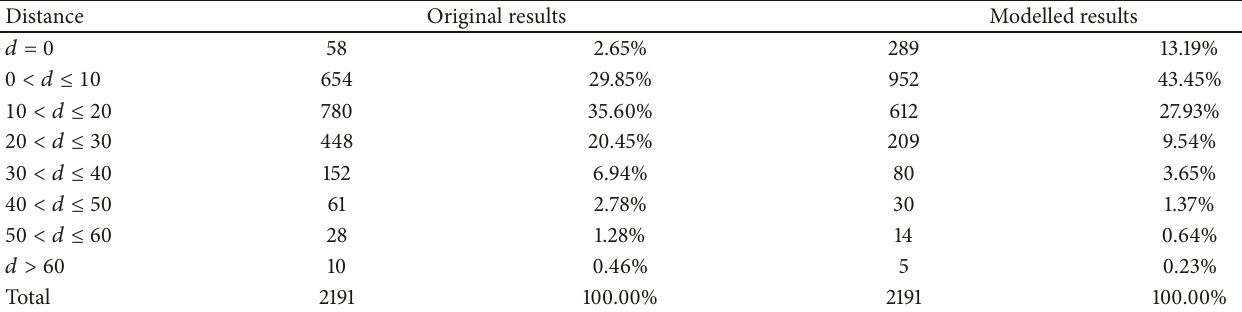
Table 2: Efficiency comparison of running taxis. The data in the 2nd and 4th columns are numbers of taxis with corresponding distances. Distance Original results Modelled